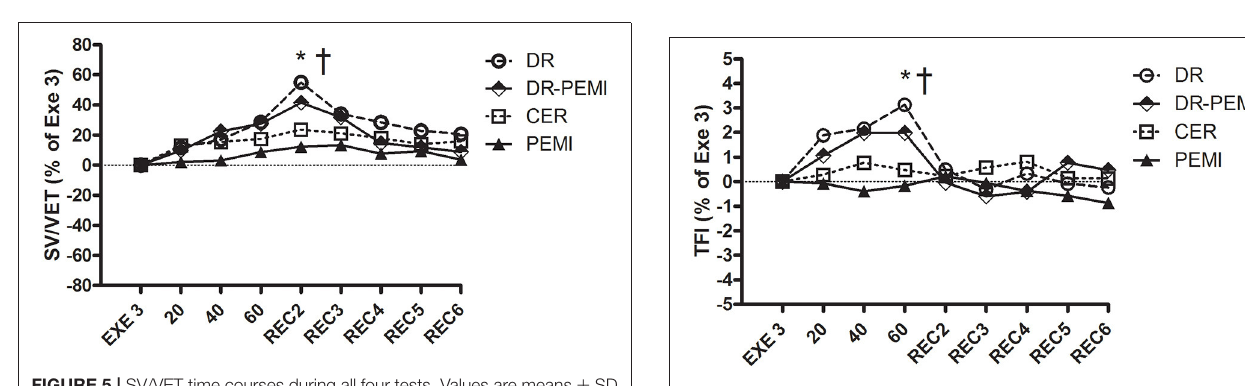
FIGURE 8 | TFI Values are means ± SD percentages of the end of handgrip (EXE3). * = P < 0.05 vs. EXE3. † = P < 0.05 vs.